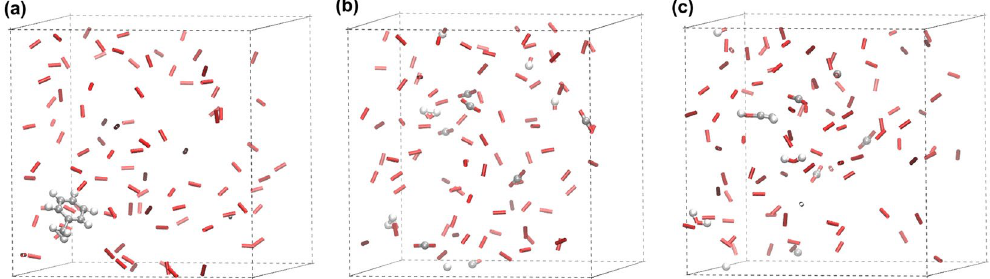
Figure 1. ( a ) Initial configuration of the equilibrated toluene/oxygen system (T = 2500 K, density = 0.15 g/cm 3 ). ( b ) Final configuration after a 3000 ps NVT-MD simulation (T = 2500 K, density = 0.15 g/cm 3 , Efield = 0.2 V/Å) was performed. ( c ) Final configuration after a 3000 ps NVT-MD simulation (T = 2500 K, density = 0.15 g/cm 3 , Efield = 0 V/Å) was performed. Molecular oxygen is represented by sticks and toluene and oxidation products are represented using the ball and stick